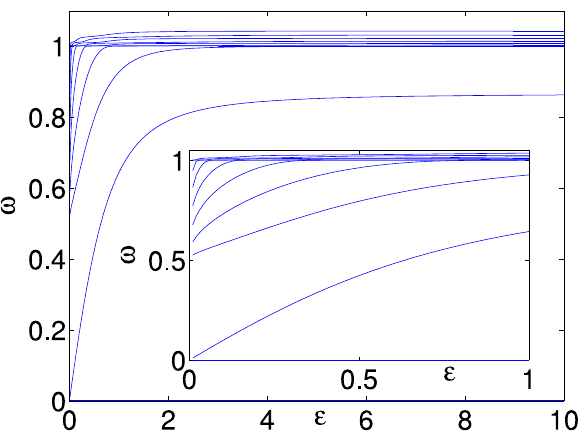
Figure 3 . The lowest (positive) eigenfrequencies of the linearization problem given in eq. (2.5). The phonon band (i.e., the continuous spectrum) starts at ω = 1, hence eigenfrequencies below that critical point are bifurcating internal modes. One can clearly distinguish (also through the inset) the progressive increase in the number of internal modes as ǫ